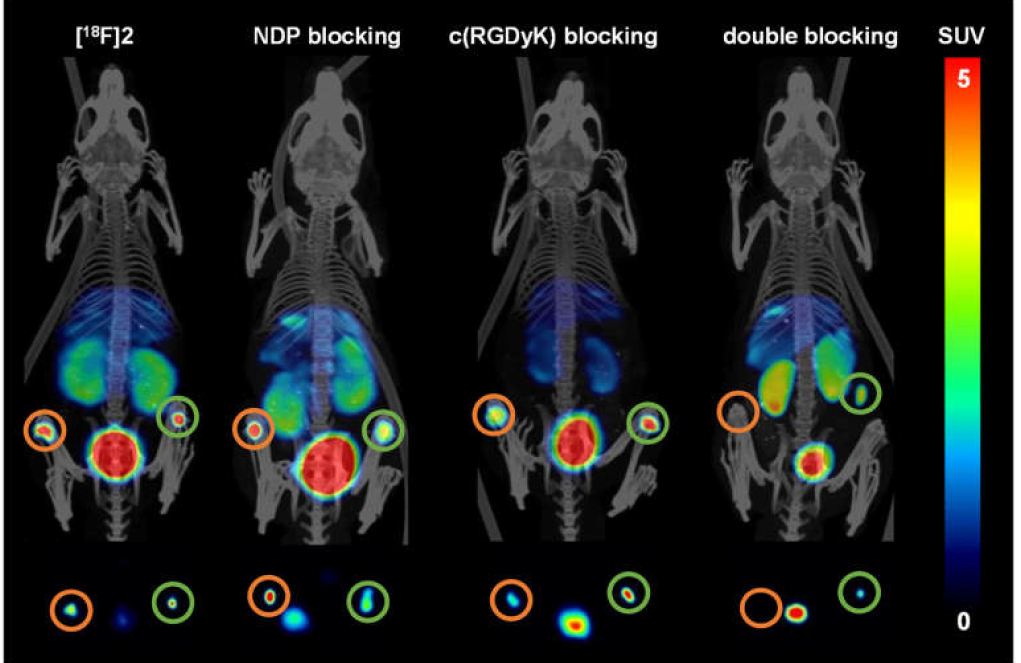
Figure 6. Depiction of the PET/CT images given as maximum intensity projections (MIPs) applying [ 18 F] 2 as the radioligand ( n = 3 for each group). From left to right: [ 18 F] 2 without blocking; NDP blocking; c(RGDfK) blocking; blocking using both agents. Shown are MIPs obtained for 50–90 min PI (post-injection). Upper row: coronal slices; bottom row: transaxial slices at the tumor level. Circled in orange: U87MG tumors; circled in green: B16F10